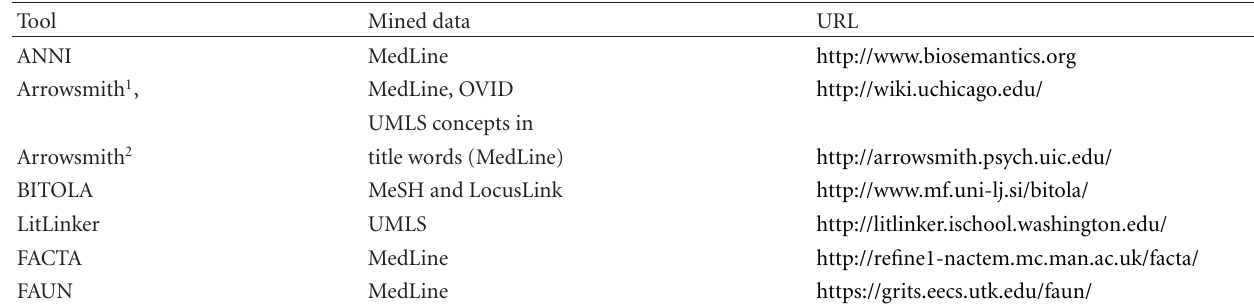
Table 1: Examples of literature-based knowledge discovery